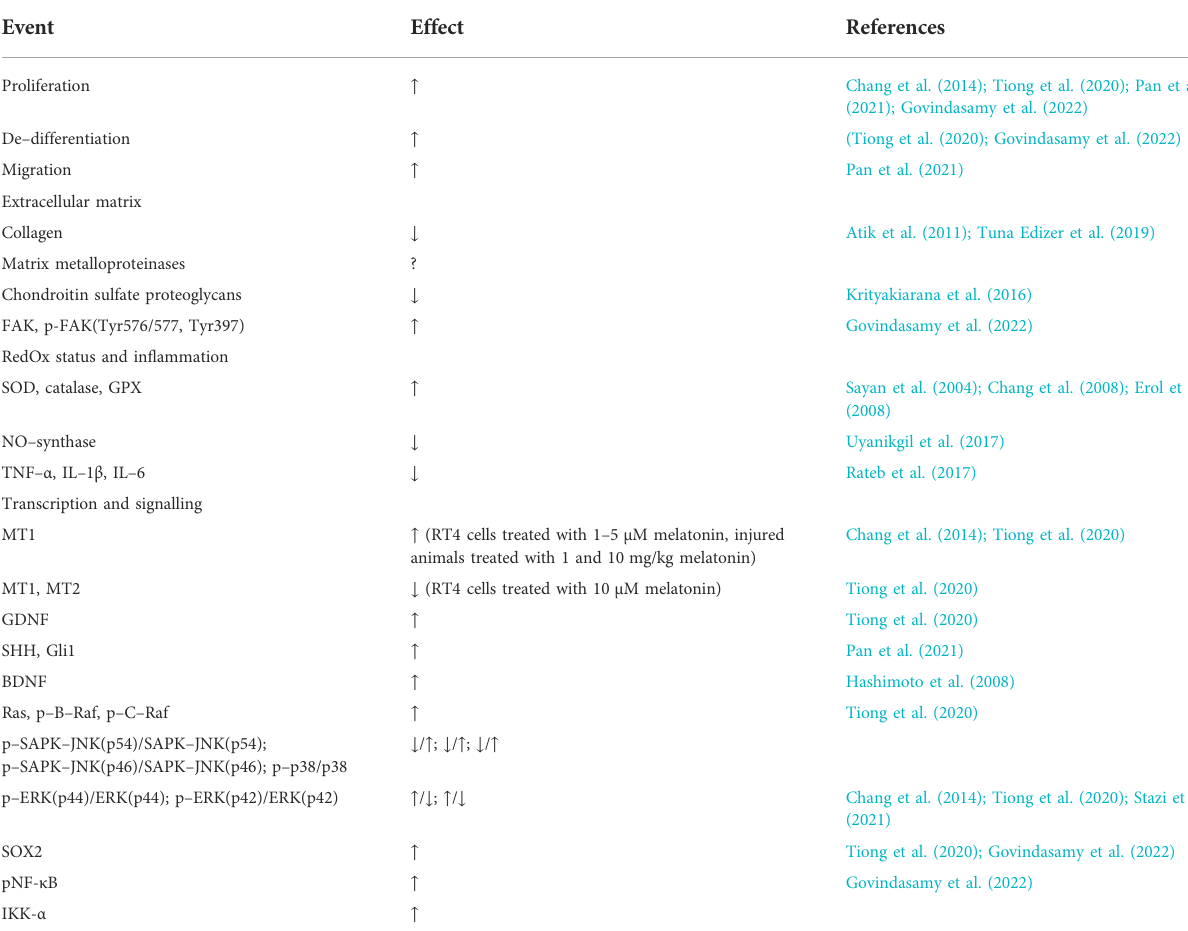
TABLE 1 Effects of melatonin on Schwann cells in the scenario of nerve